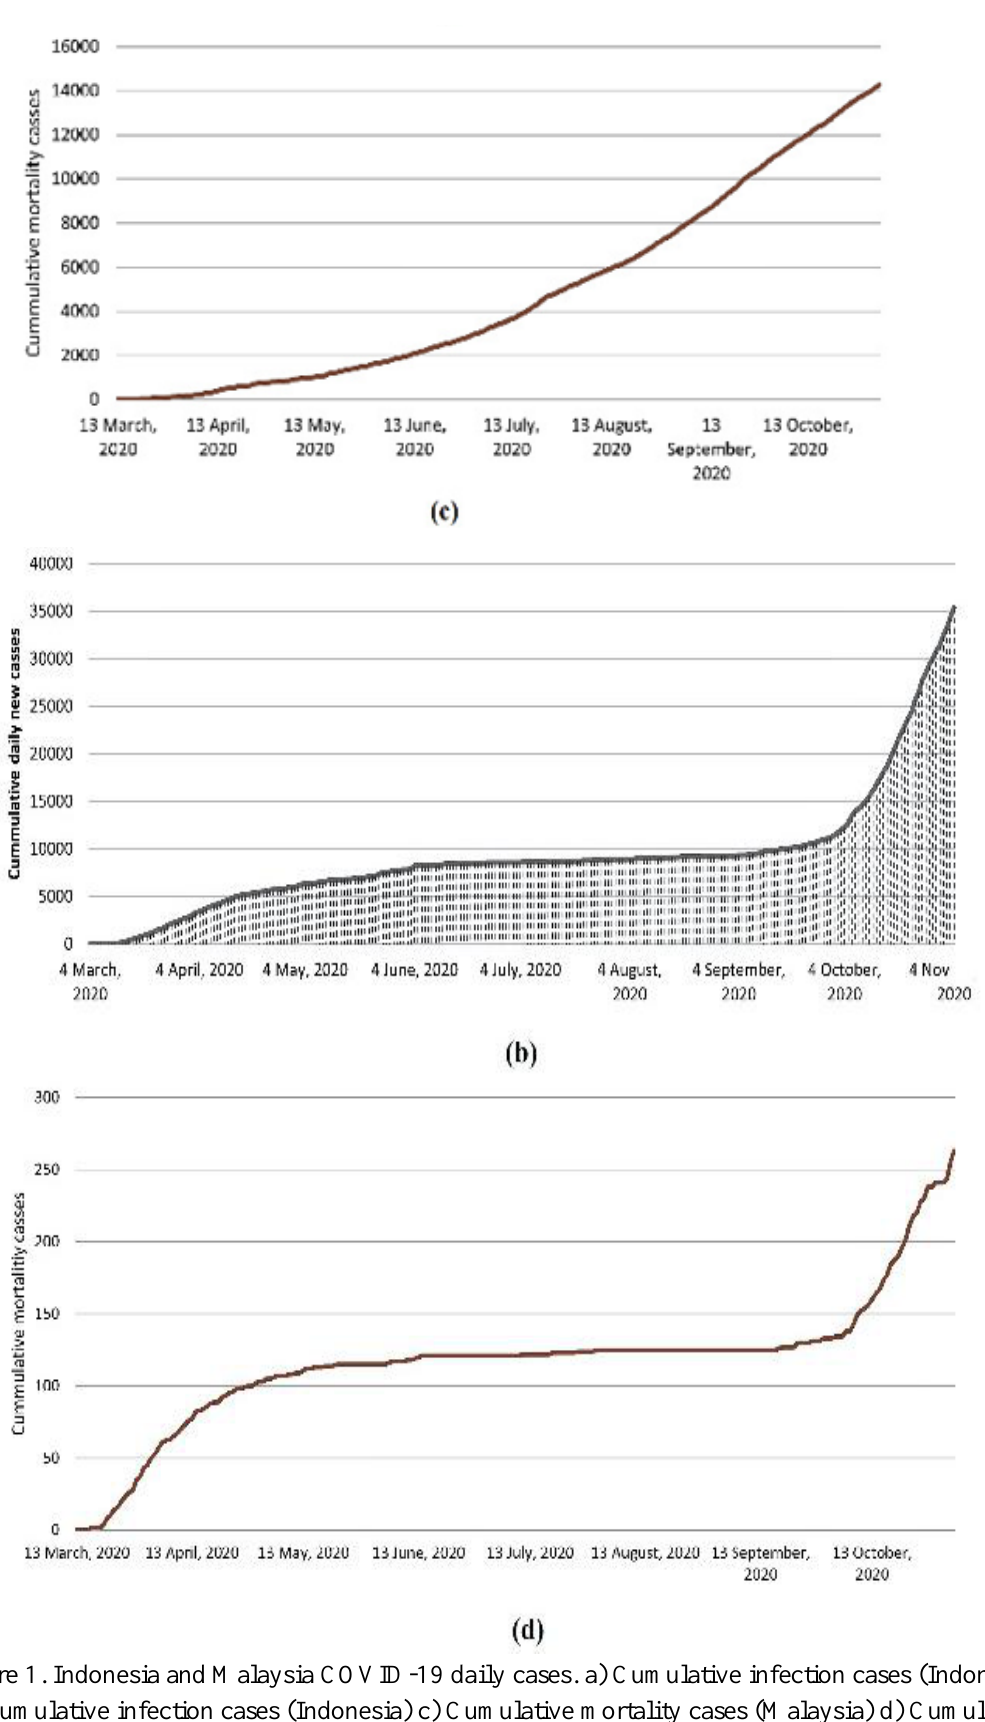
Figure 1. Indonesia and Malaysia COVID-19 daily cases. a) Cumulative infection cases (Indonesia) b) Cumulative infection cases (Indonesia) c) Cumulative mortality cases (Malaysia) d) Cumulative mortality cases